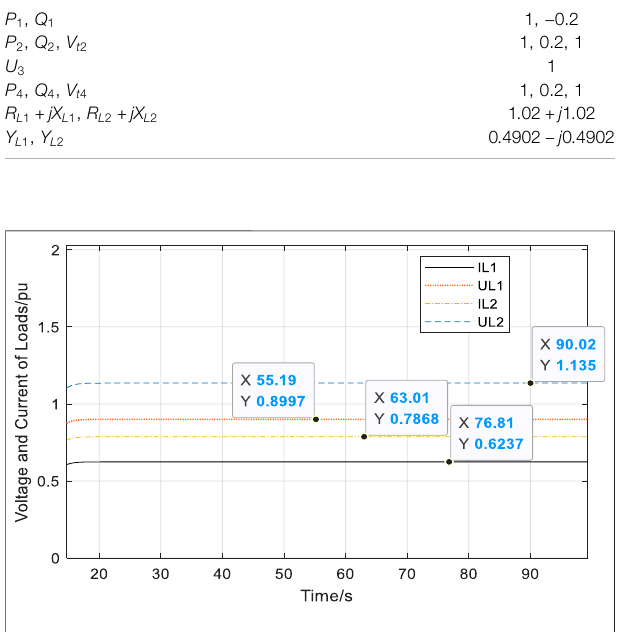
FIGURE 8 | Voltage and current curves on load under operation condition I of the improved APME